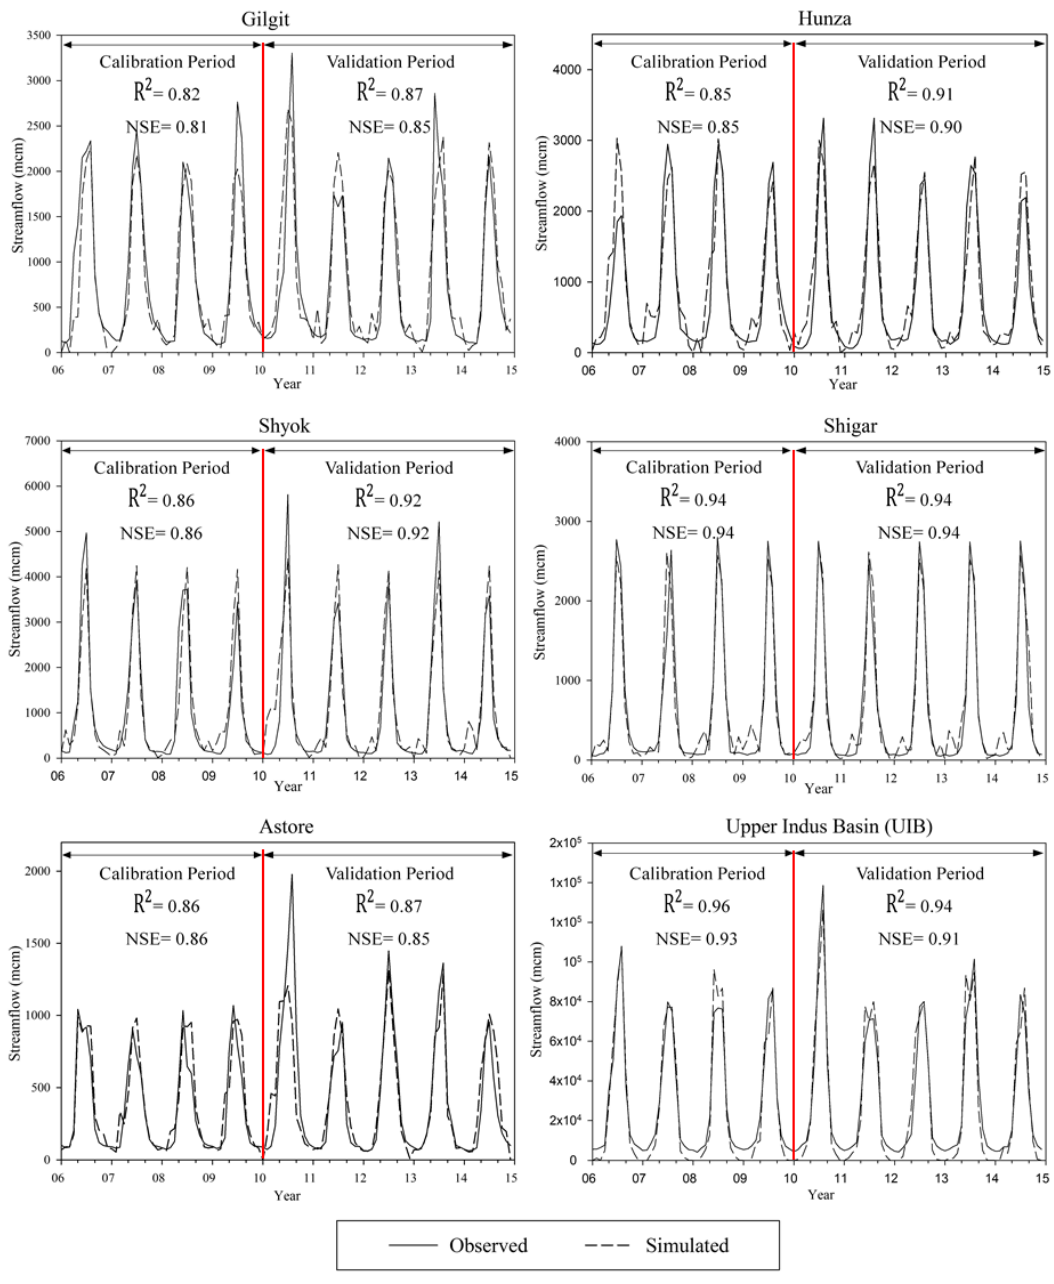
Figure 9. The calibration and validation of the five sub-catchments and the entire Upper Indus Basin (UIB).